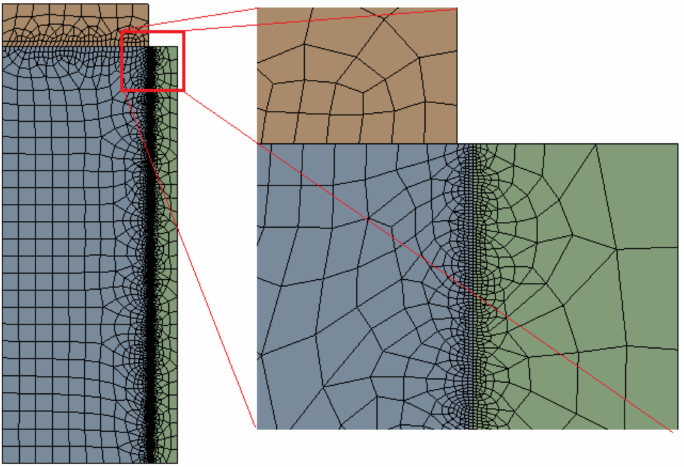
Figure 5. Meshed assembly of the experimental cell, showing the element density near to bonded